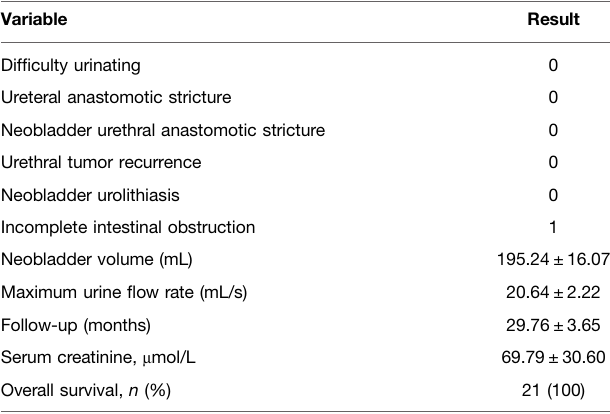
TABLE 4 | 1-year postoperative characteristics.